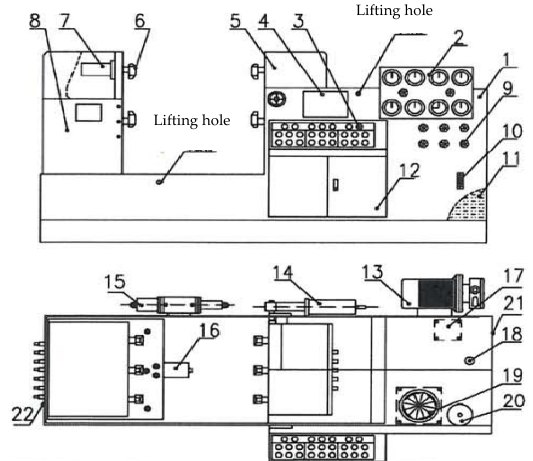
Figure 16. Structural schematic diagram. Components: 1. Hydraulic control station; 2. Panel of pressure gauge; 3. Panel of control button; 4. Pressure checklist; 5. Turning bench; 6. Clamping claws; 7. Clamping oil cylinder; 8. Moving bench; 9. Control valves; 10. Oil volume gauge; 11. Oil tank; 12. Electric box; 13. Low-pressure water supply pump; 14. Turning oil cylinder; 15. High-pressure water supply pump; 16. Moving oil cylinder; 17. Hydraulic and integrated components; 18. Oiling port; 19. Hydraulic motor and oil pump; 20. Pressurizing oil cylinder; 21. Oil draining; 22. Water draining [30].